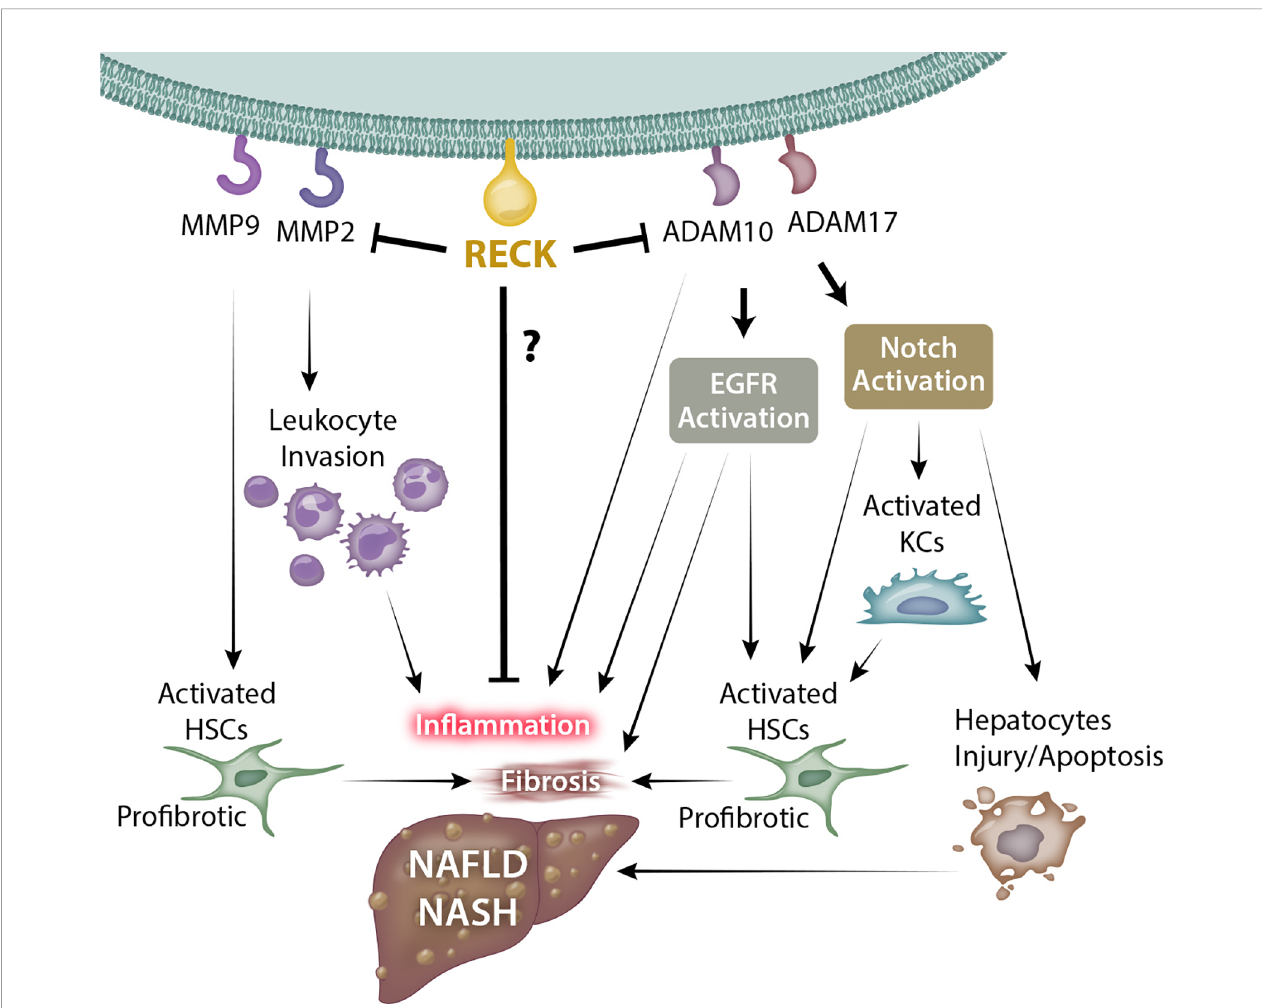
FIGURE 1 | Possible mechanism through which RECK in fl uences NAFLD/NASH development and pathogenesis. RECK ’ s inhibition of the gelatinases MMP2 and MMP9 may in turn reduce leukocyte invasion into the hepatic parenchyma and hepatic stellate cell activation. In addition, RECK inhibits the sheddases ADAM10 and ADAM17, which consequently may inhibit the release of proin fl ammatory cytokines from hepatic cells, as well as reduce activation of EGFR and Notch pathways, both of which contribute to in fl ammation and fi brosis of liver. © Copyright 2021 by The Curators of the University of Missouri, a public